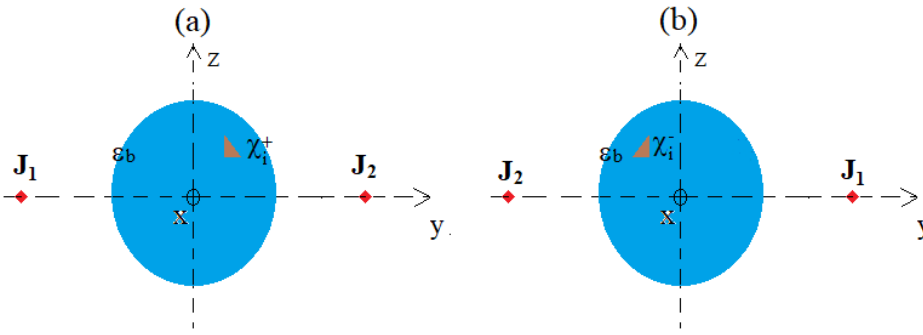
Figure A1. Conceptual scheme of the problem underlying the proposed differential MWI strategies: ( a ) point of view of the source J 1 ; ( b ) point of view of the source J 2 . Due to the symmetry, the point of view of J 2 is the same of that of J 1 except for χ i + which appears to J 2 at the mirror position of how it is appears to J 1 (see Figure A1b). Therefore, denoted with ( E 1 , H 1 ) the field radiated by J 1 , evaluated in a reference system with the y -axis pointing toward J 2 (see Figure A1a), and with ( E 2 , H 2 ) the field radiated by J 2 , evaluated in a reference system with the y -axis pointing toward J 1 (see Figure A1b), it is straightforward to show that the difference field E = E 1 − E 2 , H = H 1 − H 2 satisfies